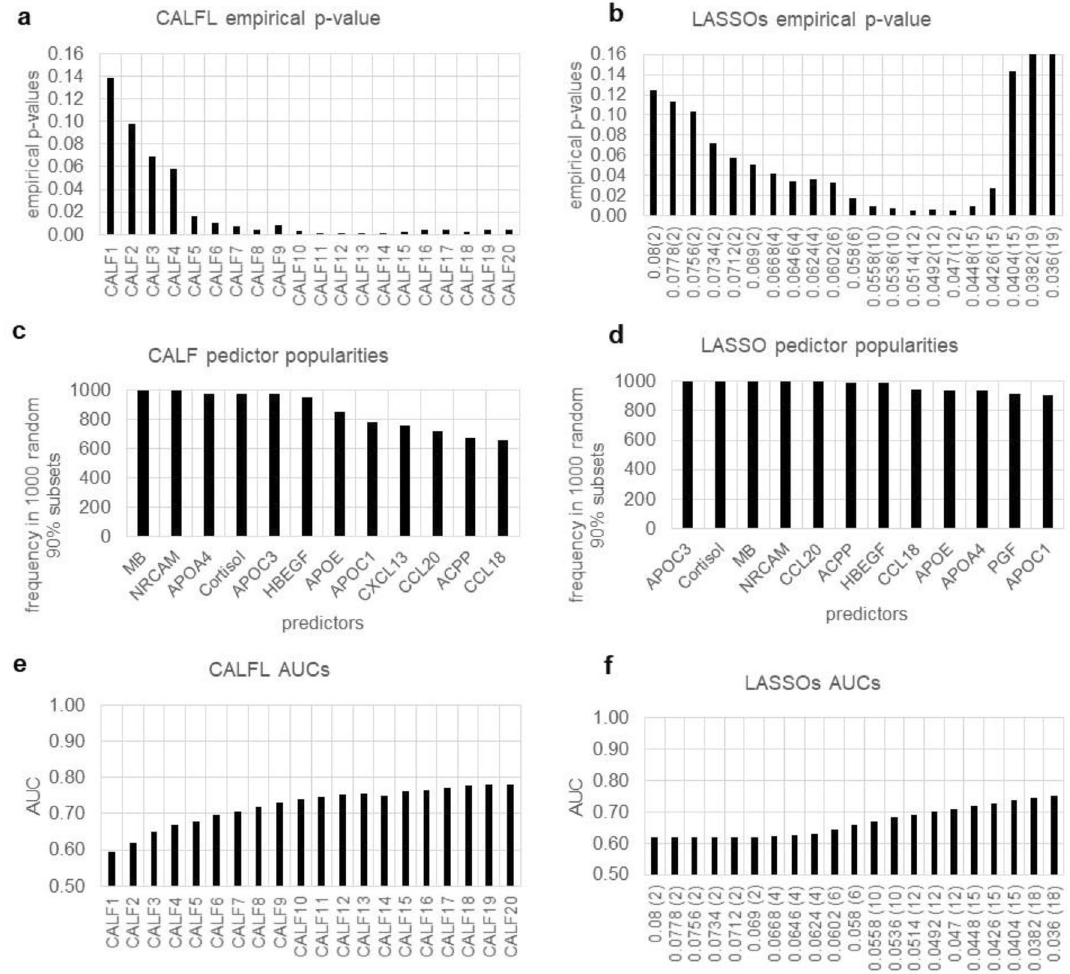
Figure 4. Comparison of CALF and LASSO logistic regression results for Example 4. ( a ) CALF6 has an empirical p-value 0.010. ( b ) Comparable empirical p-values for LASSO require at least 10 predictors, risking overfitting. ( c ) A cliff occurs at six predictors for CALF, but ( d ) LASSO has no comparable cliff. ( e ) For CALF6 the AUC is a weak 0.696, but ( f ) LASSO requires at least 10 predictors to achieve the same, risking